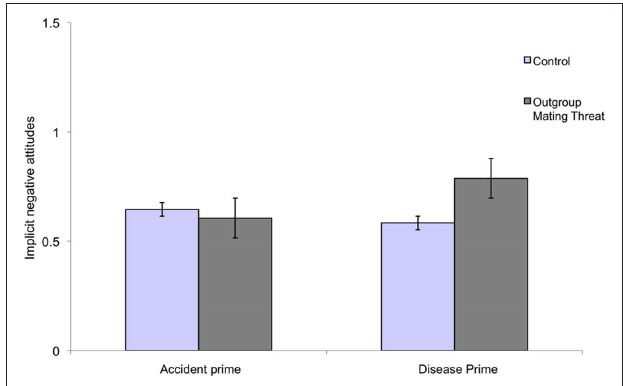
Figure 2 | implicit negative attitudes as function of experimentally manipulated out-group mating threat and disease salience for men (error bars indicate standard